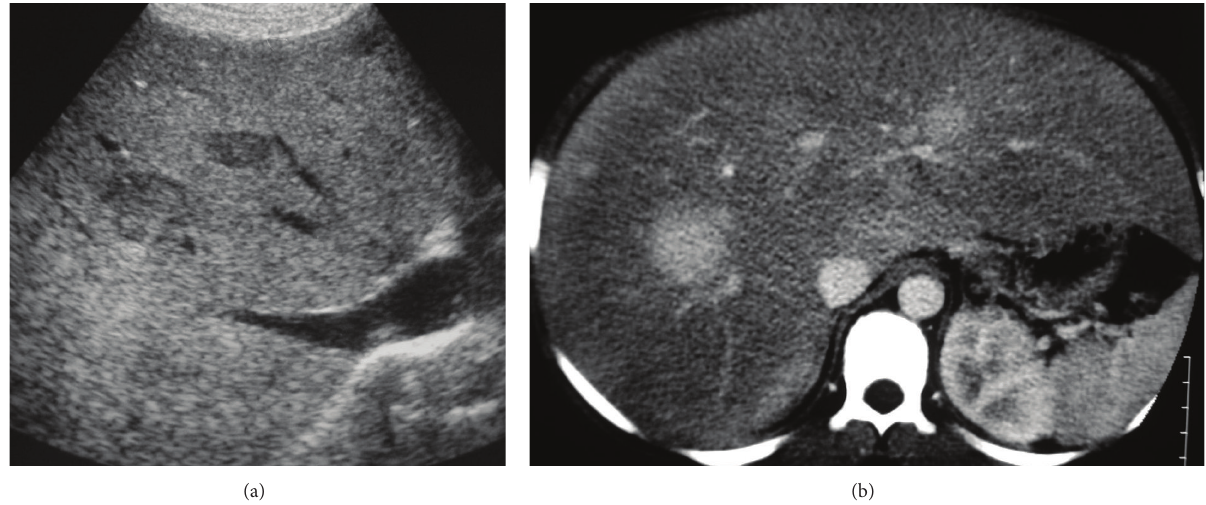
Figure 5: Fourteen-year-old boy with glycogen storage disease type I and multiple HCA measuring from 1 to 3 cm diameter. (a) US shows an enlarged hyperechoic liver (steatotic) with well-delimited hypoechoic nodules. (b) CT performed at the arterial phase after contrast injection shows enlarged steatotic liver with multiple nodules that are strongly